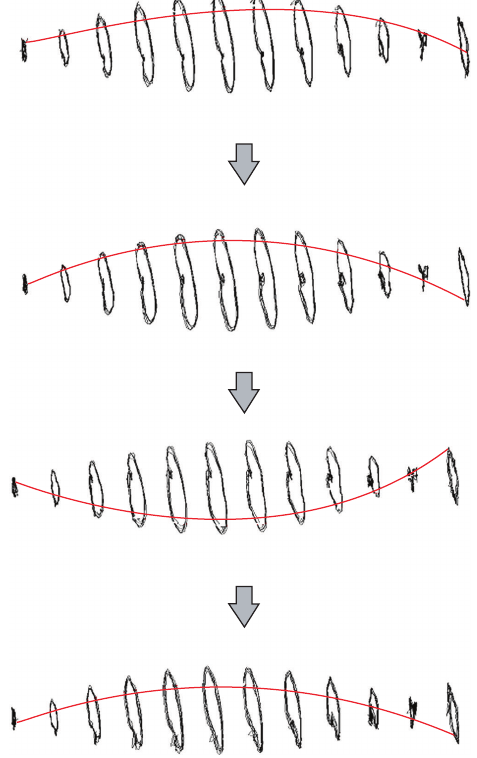
Figure 10: Orbital evolution of the flexible rotor passing through the 2X resonance of the second forward critical speed.